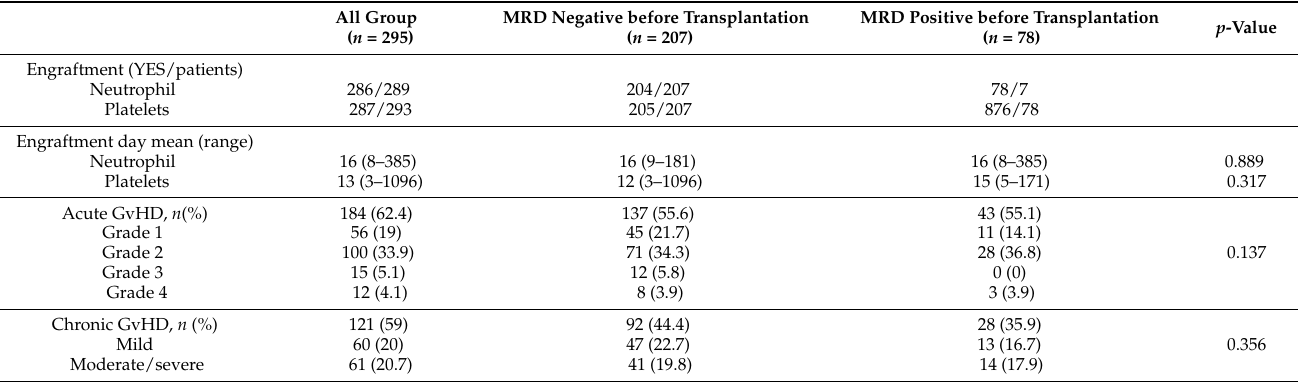
Table 2. Toxicities: engraftment and